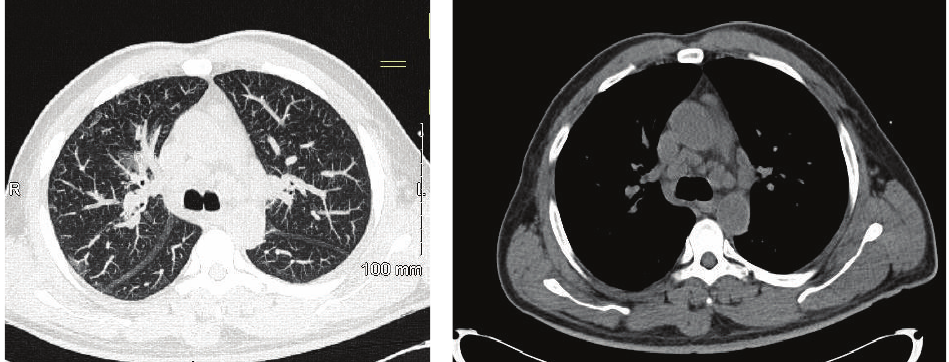
Figure 1: CT chest without IV contrast. Computed tomography without intravenous contrast showing mediastinal and hilar adenopathy.